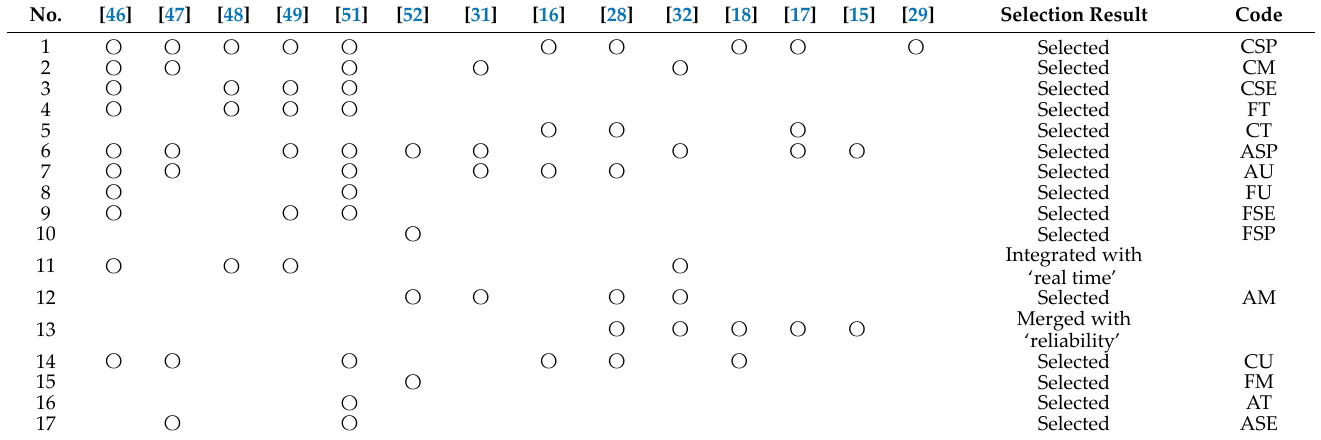
Table 1. Results of the literature review conducted for factor generation.